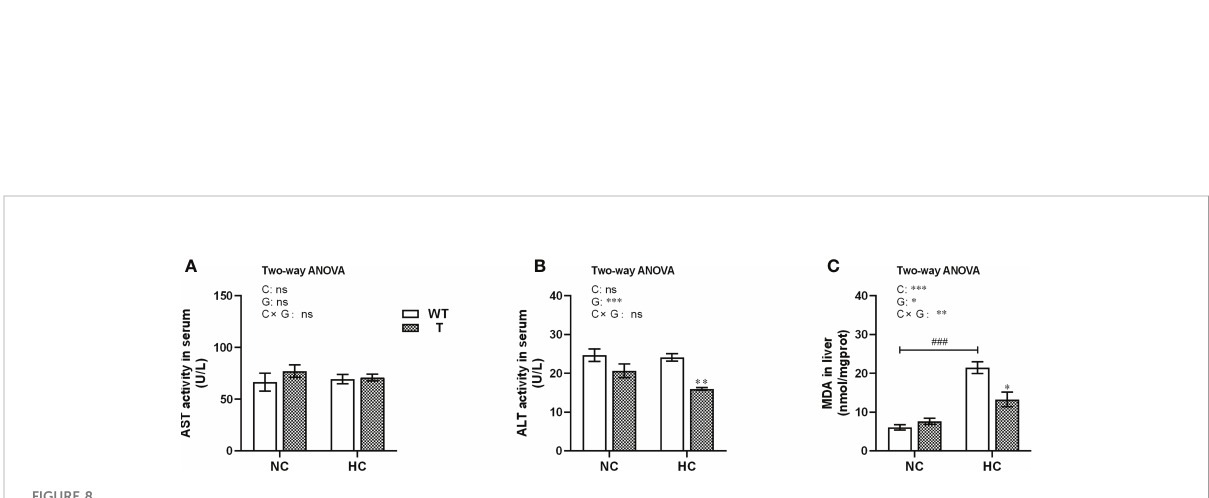
FIGURE 8 Indicators of liver damage of T and WT common carp fed a normal or high-carbohydrate diet. (A, B) Serum activity levels of aspartate aminotransferase (AST) and alanine aminotransferase (ALT). (C) Malondialdehyde (MDA) content in the liver (n = 6). * and ** indicate a signi fi cant difference ( P < 0.05 and P < 0.01, respectively) in different strains at same dietary starch content. ### indicate a signi fi cant difference ( P < 0.001) in the same strain with different dietary starch contents. In two-way ANOVA, C, carbohydrate; G, GH. * P < 0.05, ** P < 0.01, *** P < 0.001; ns, indicates no signi fi cance.